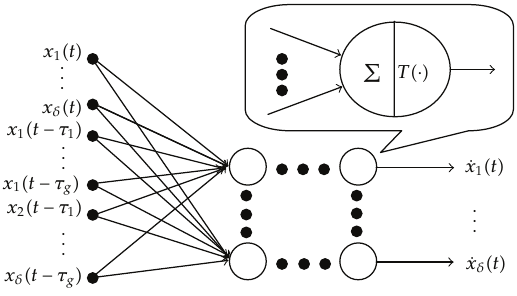
Figure 1: An NN model for 𝑁 𝑑